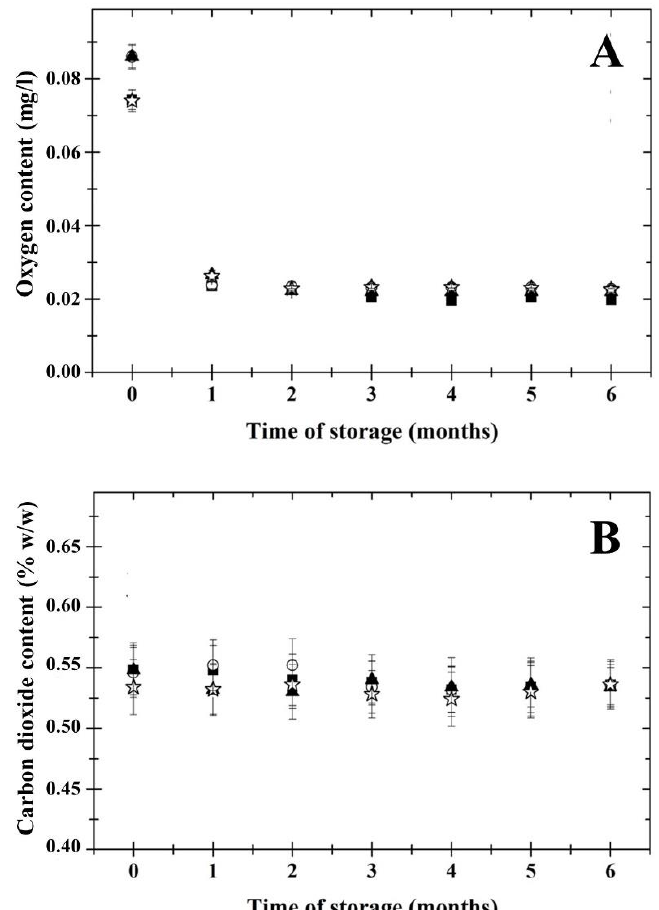
Figure 1. Development of CO 2 content (% w / w ; part A ) and O 2 content (mg/L; part B ) in the Czech lager beer samples during a 6 months cold storage period at 4 ± 2°C. The examined beer samples presented different original wort extract values ( ■ — 10.0% w / w ; ○ — 11.0% w / w ; ▲ — 11.5% w / w ; ☆ — 12.0% w / w ). The results are expressed as means; the error bars represent standard deviation ( n = 6).